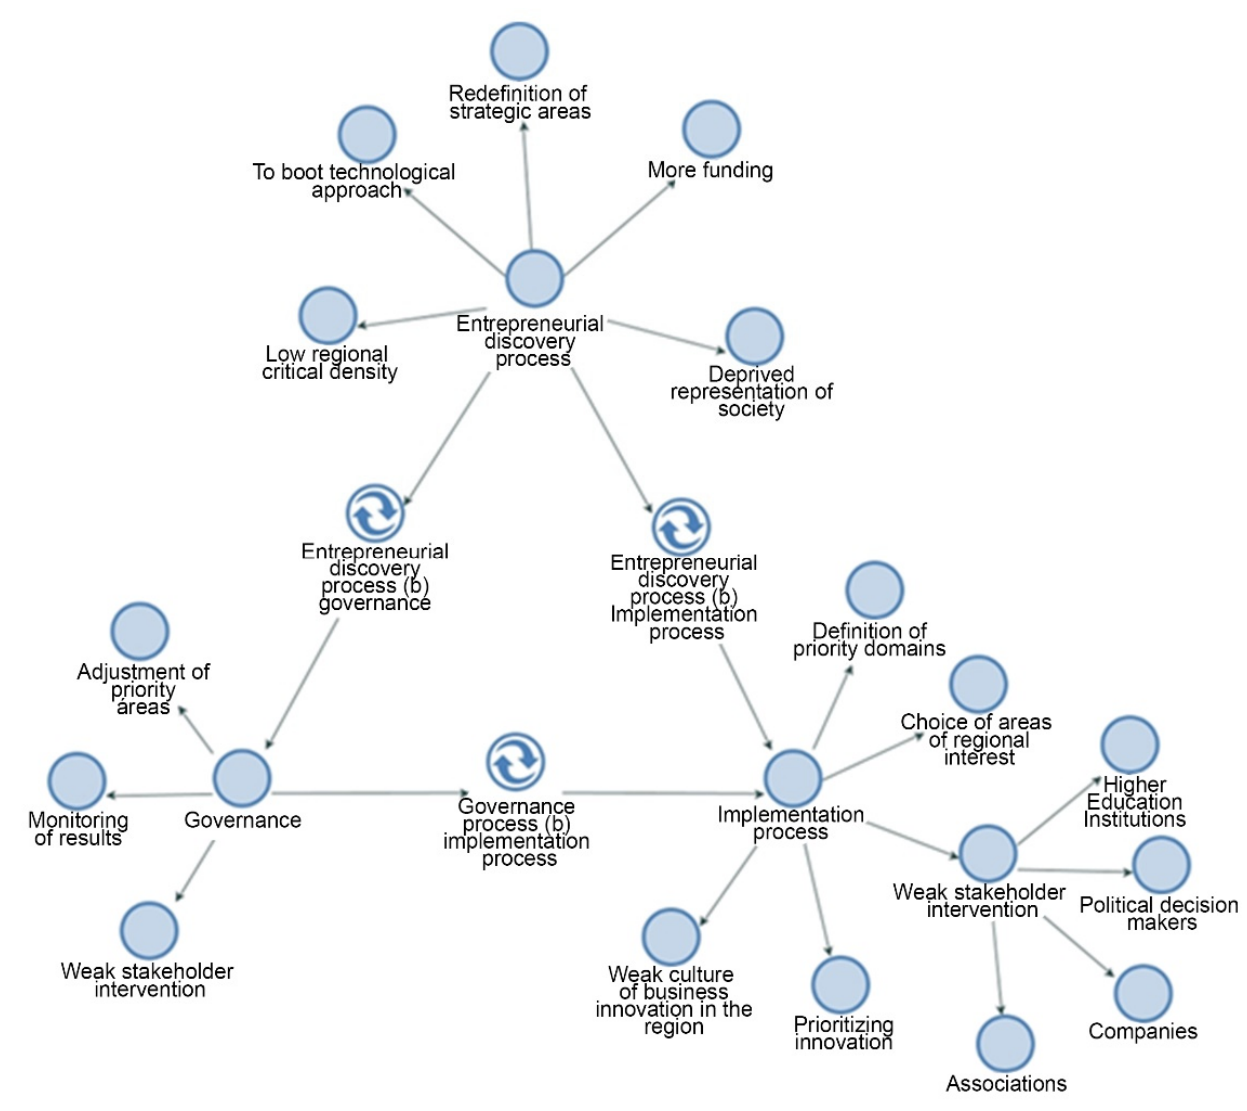
Figure 2. NVivo Node Map and Relationship .